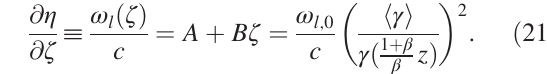
FIG. 3. Calculated on-axis spectra for a circularly polarized laser pulse with parameters ω l; 0 ¼ 1 . 77 × 10 15 [ 1 W ¼ 300 × 10 − 4 ½ cm (cid:2) , and electron parameters N 0 spread is linear in the ˆ x direction with a magnitude Δ γ intensity of a 0 ¼ 10 − 1 . The PW monoenergetic electron bunch case is reproduced when using a chirped laser pulse as given by Eq. (13). Right: a 0 ¼ 1 and the chirp of the laser pulse given by Eq.